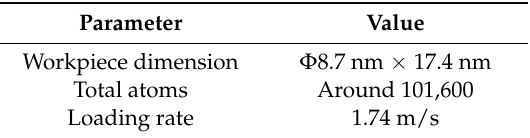
Figure 4. Crystal orientations for tension and compression. Table 1. Molecular dynamics (MD) simulation parameters for tension and compression.